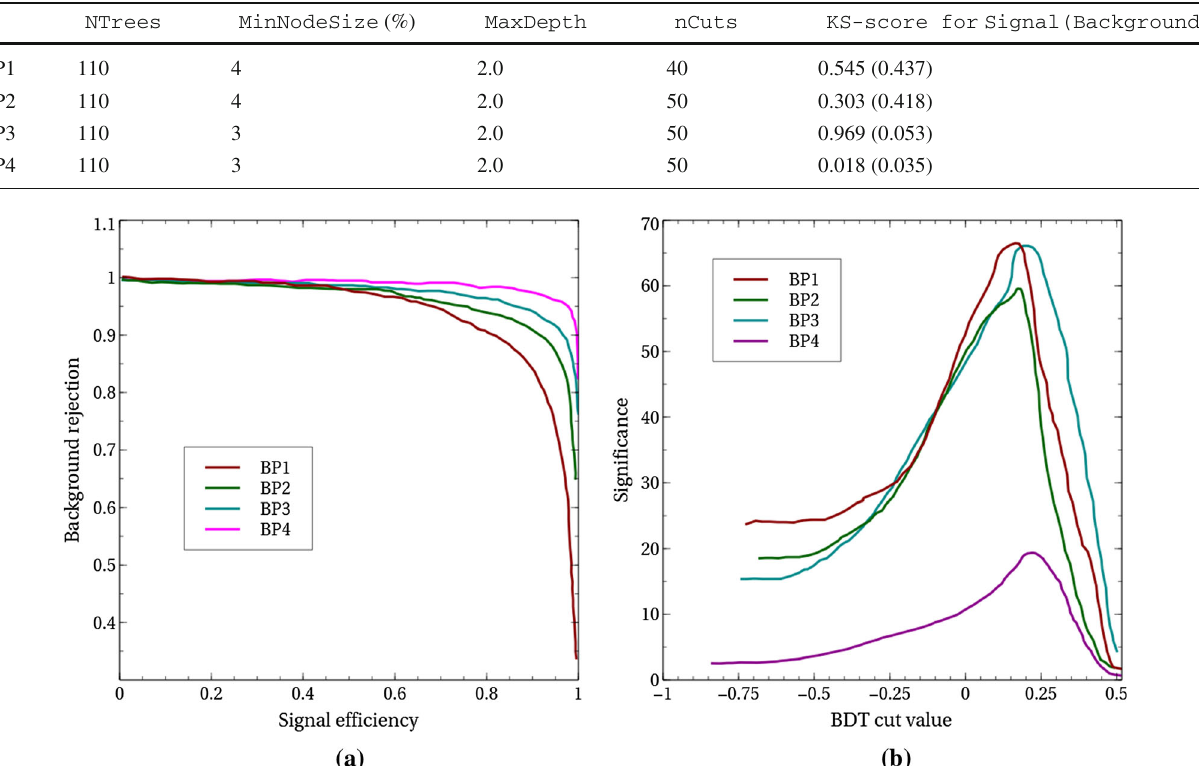
Fig. 2 (a) ROC curves for chosen benchmark points for 2 (cid:10) + E / T channel. (b) BDT-scores corresponding to BP1, BP2, BP3 and BP4 for 2 (cid:10) + E / T channel Table 8 The signal and background yields at 1 TeV ILC with 100 fb − 1 integrated luminosity for BP1,BP2, BP3 and BP4 along with luminosity required for 5 σ significance for the e + e − → 2 (cid:10) + E / T channel after performing the BDTD analysis Benchmark